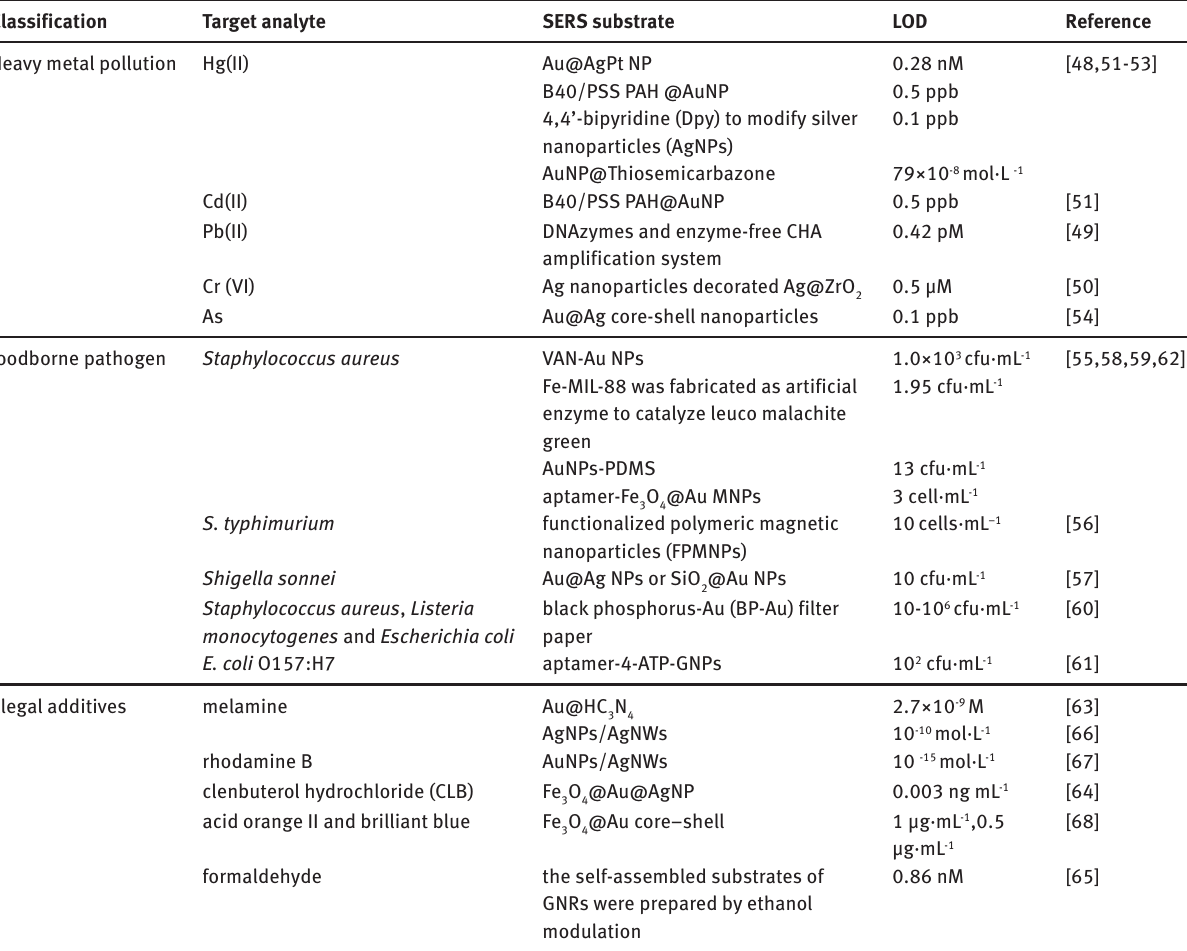
Table 1: The application of SERS in food safety detection